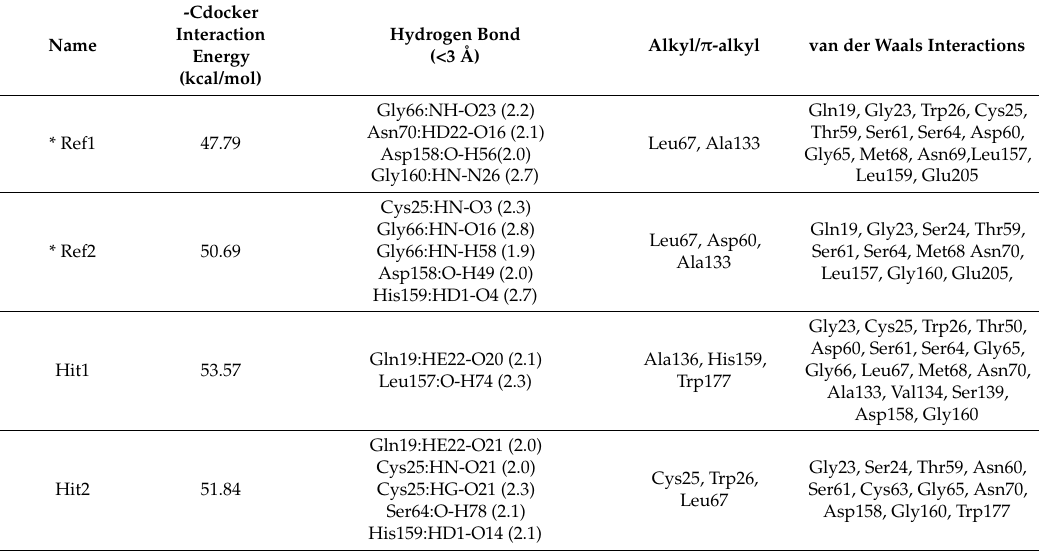
Figure 6. Graphical representation of the molecular dynamics simulation studies conducted during 50 ns. ( A ) Represents the RMSD profiles for the backbone atoms of four systems. ( B ) Demonstrates the potential energies plotted for each system. Both the figures demonstrate that the systems were well converged. ( C ) Binding pattern of reference and the Hits within the proteins binding pocket. The Hits and reference have displayed a similar binding pattern. ( D ) Number of intermolecular hydrogen bonds between protein and Hits during 50 ns simulation. The Hits have displayed a higher number of hydrogen bonds. Table 4. Comprehensive interaction of the key residues with the ligands and their dock